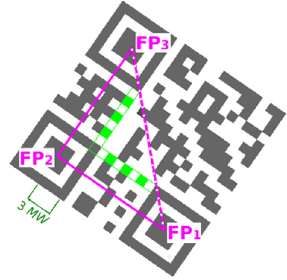
Figure 9. Timing patterns inside a QR Code.